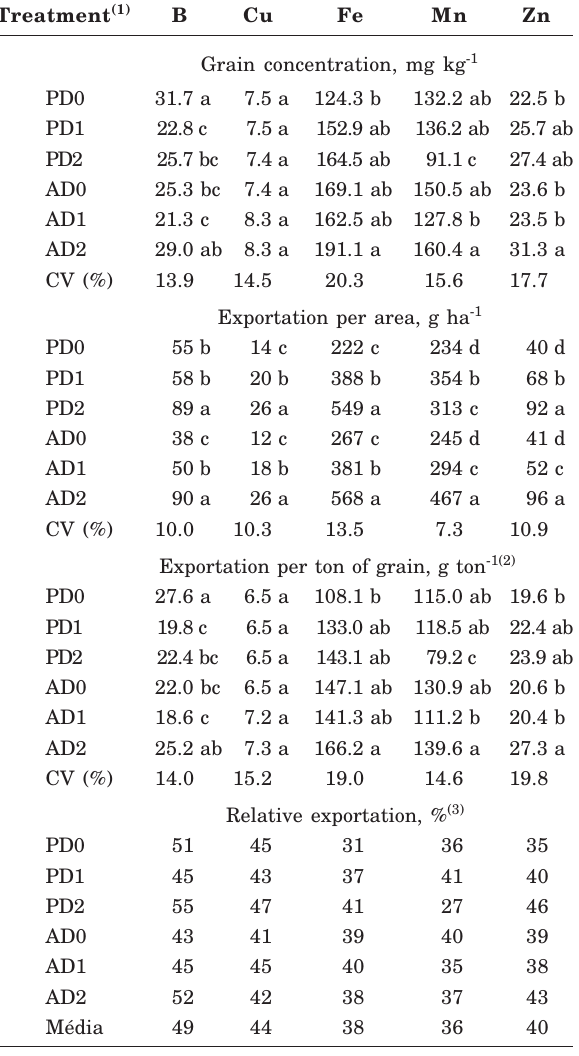
Table 3. Nutrient concentration in grain, nutrient exportation per area, nutrient exportation per ton of grain, and relative nutrient exportation by common bean cultivars, under different levels of